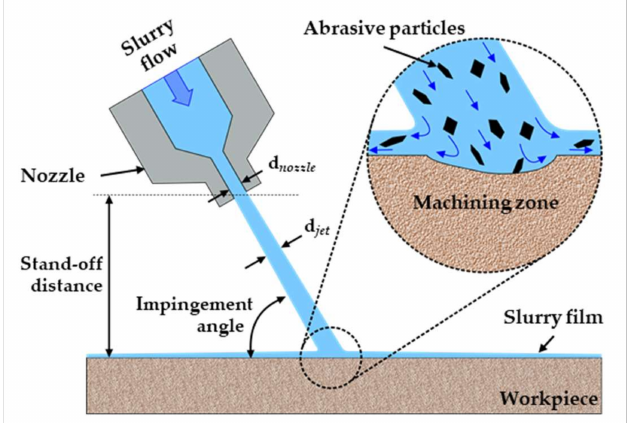
Figure 1. Sketch of the fluid jet polishing process.